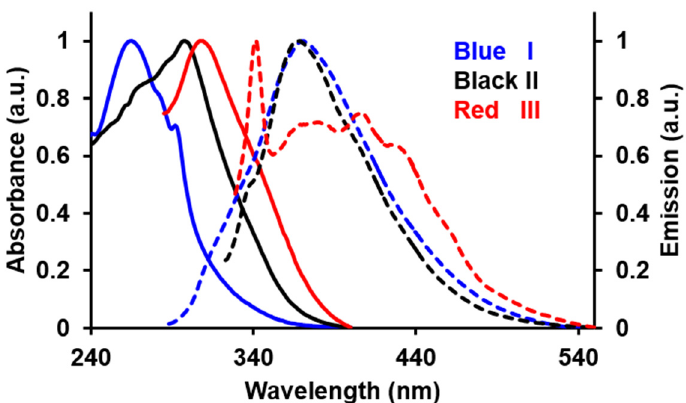
Figure 1. The normalized absorbance (solid lines) and emission spectra (dashed lines) of I, II and III in acetonitrile.